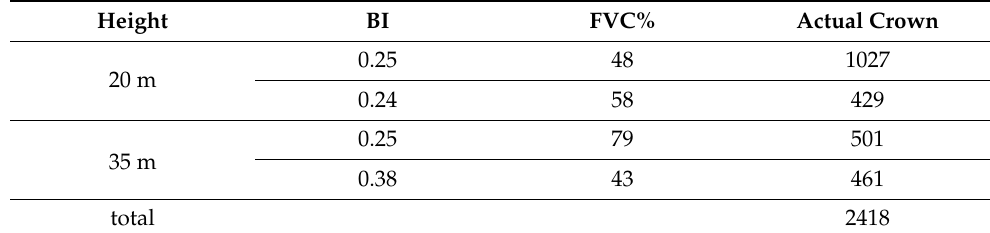
Table 2. Crown statistics of test set. BI: brightness intensity; FVC: fraction vegetation